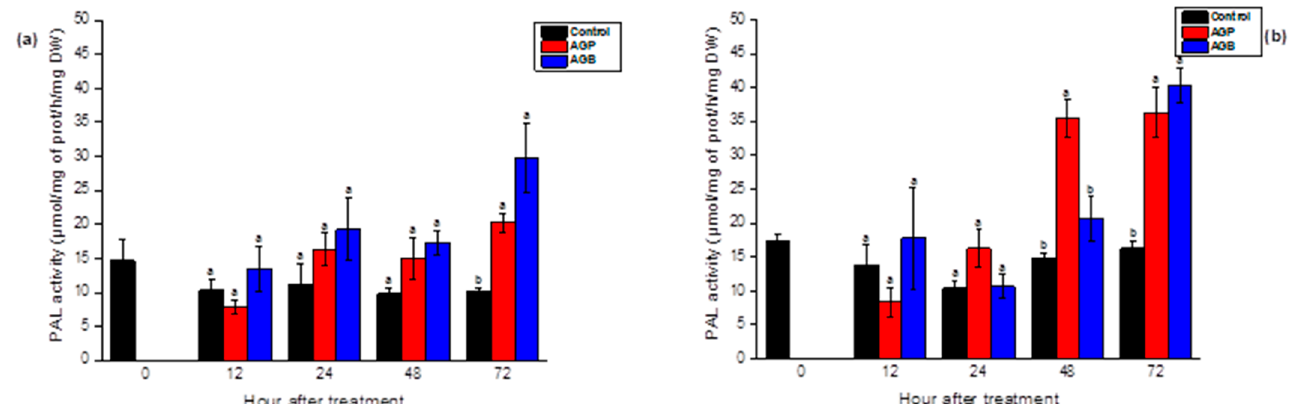
Figure 5. Stimulation of PAL activity in the leaves ( a ) and the roots ( b ) of tomato seedlings after foliar spray (20 mL) of AGB and AGP fractions (1 g/L). Each value is the mean of four repetitions ± SE. The letters (a, b, c) indicate significant differences between treatments (Control, AGB, and AGP) in each point time using a Tukey–HSD test at ( p < 0.05). Treatments presented with the same letter are not significantly different.